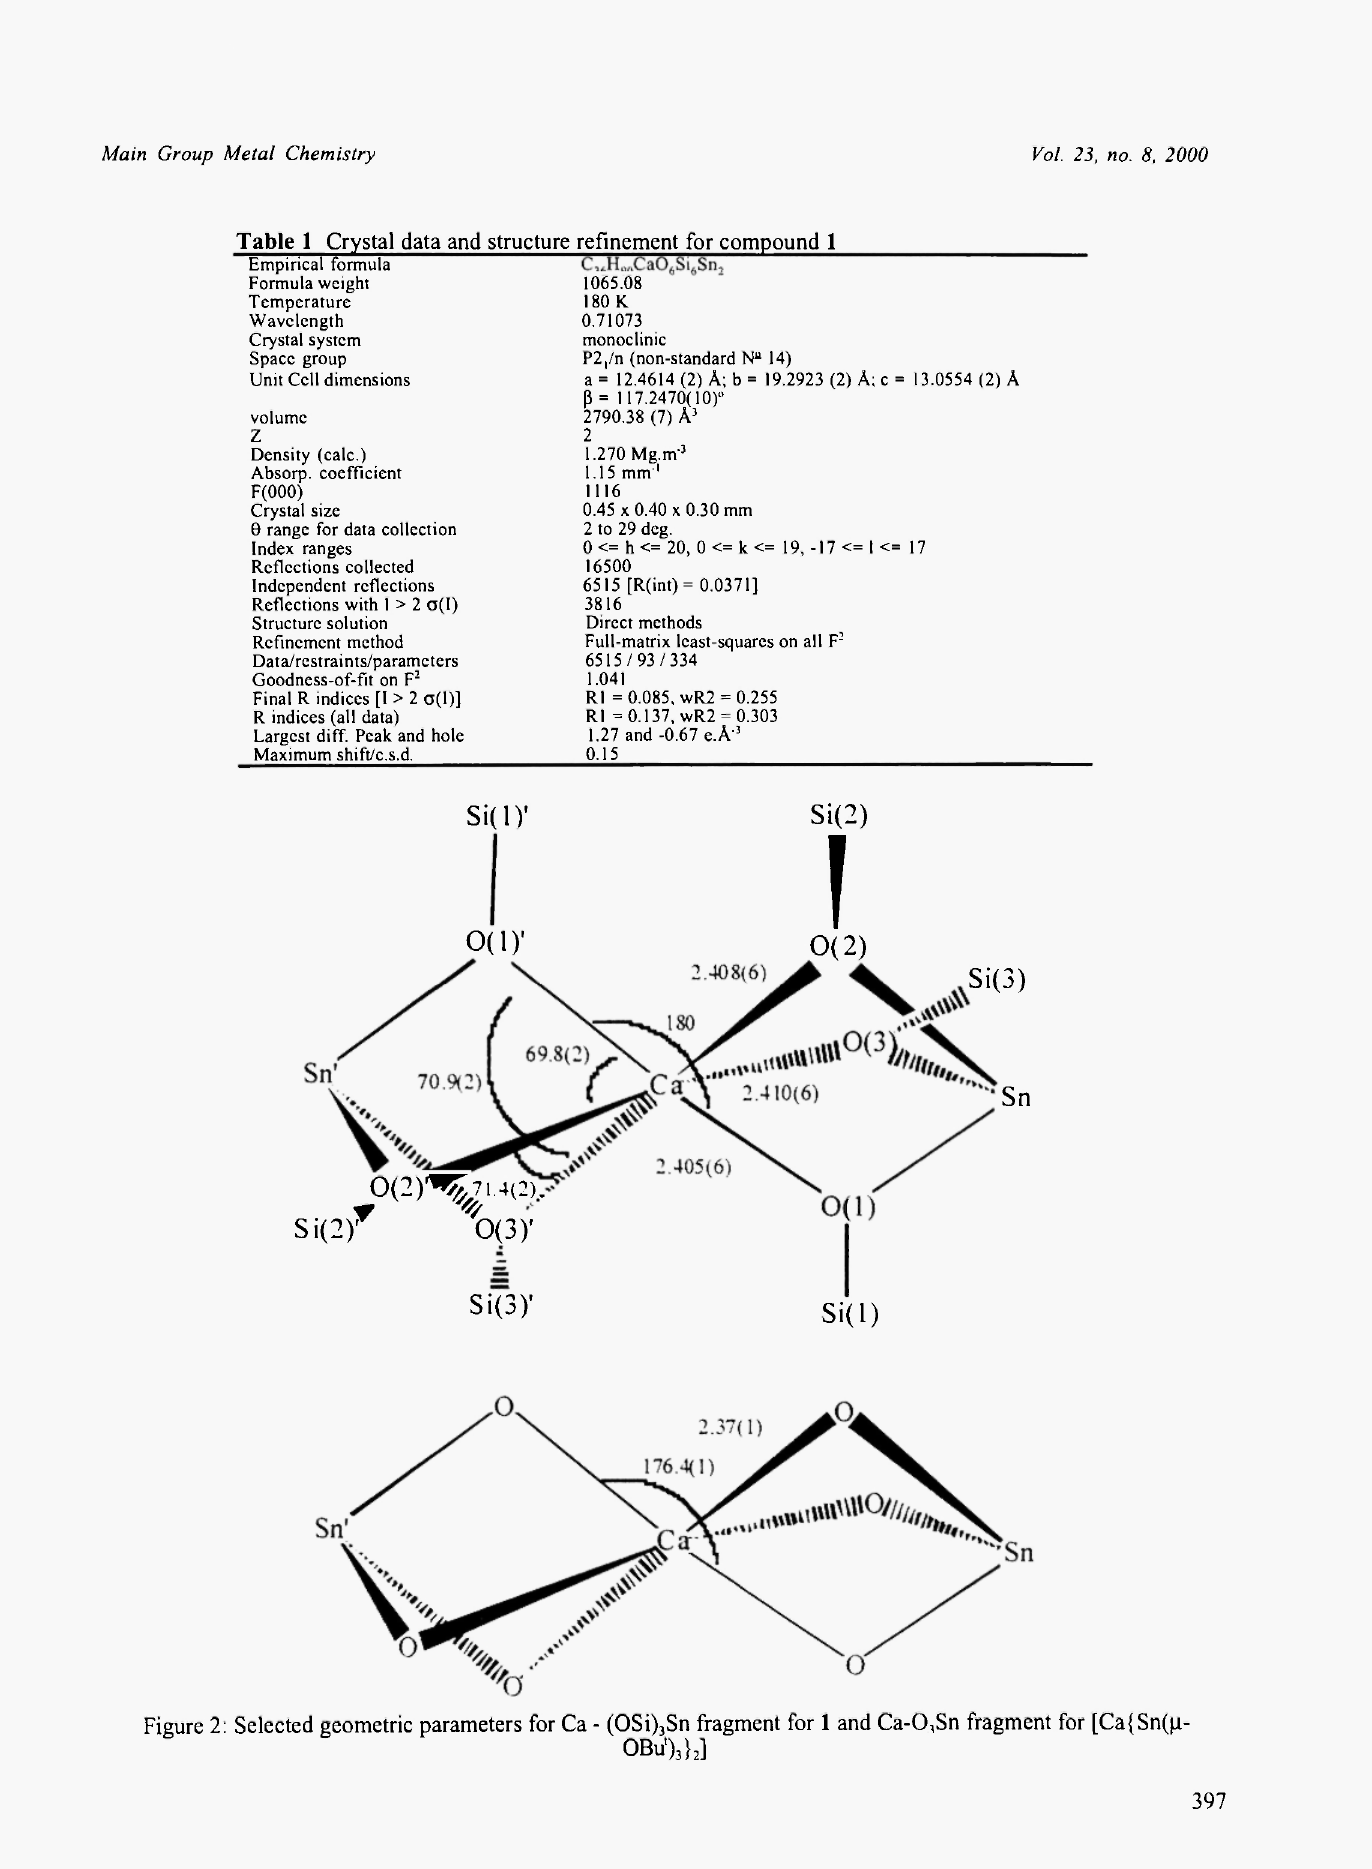
Figure 2: Selected geometric parameters for Ca - (OSi) 3 Sn fragment for 1 and Ca-C^Sn fragment for [Ca{Sn^- OB U') 3 } 2